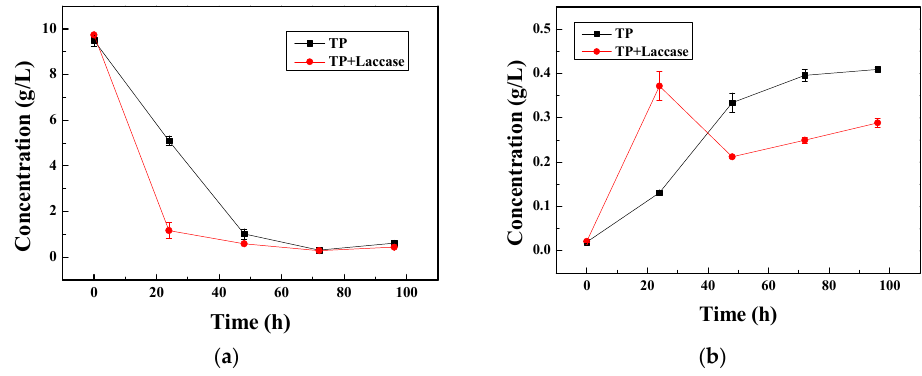
Figure 2. ( a ) Relationship between concentration of tea polyphenols and time; ( b ) Relationship between concentration of theaflavin and time.